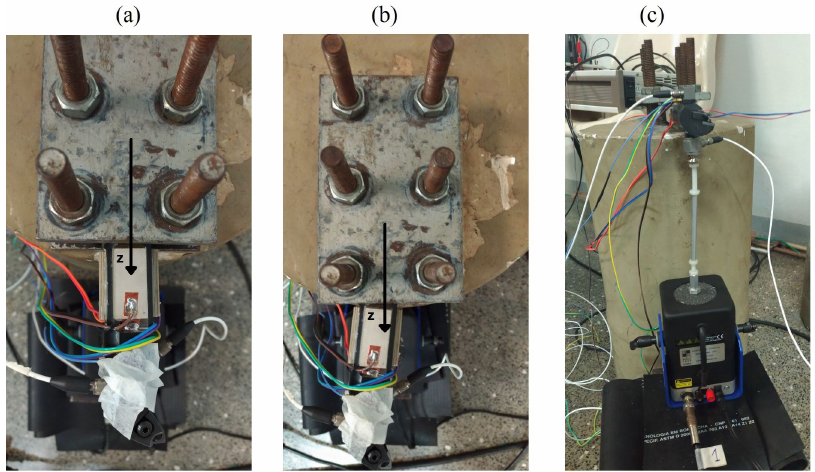
Figure 6. Experimental setup: a) first configuration - top view; b) second configuration - top view; c) lateral